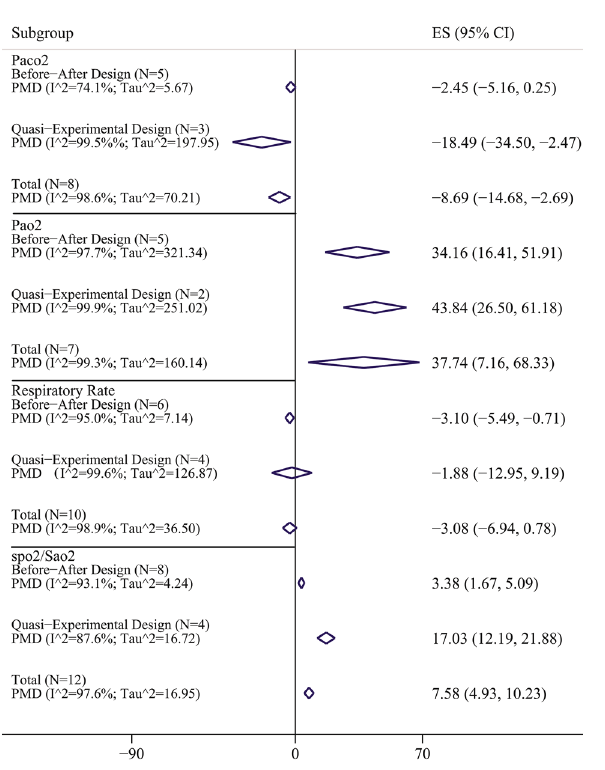
Figure 3. Pooled mean difference and 95% confidence interval of respiratory parameters based on the random effects model in total and in different study design. The diamond mark illustrates the pooled